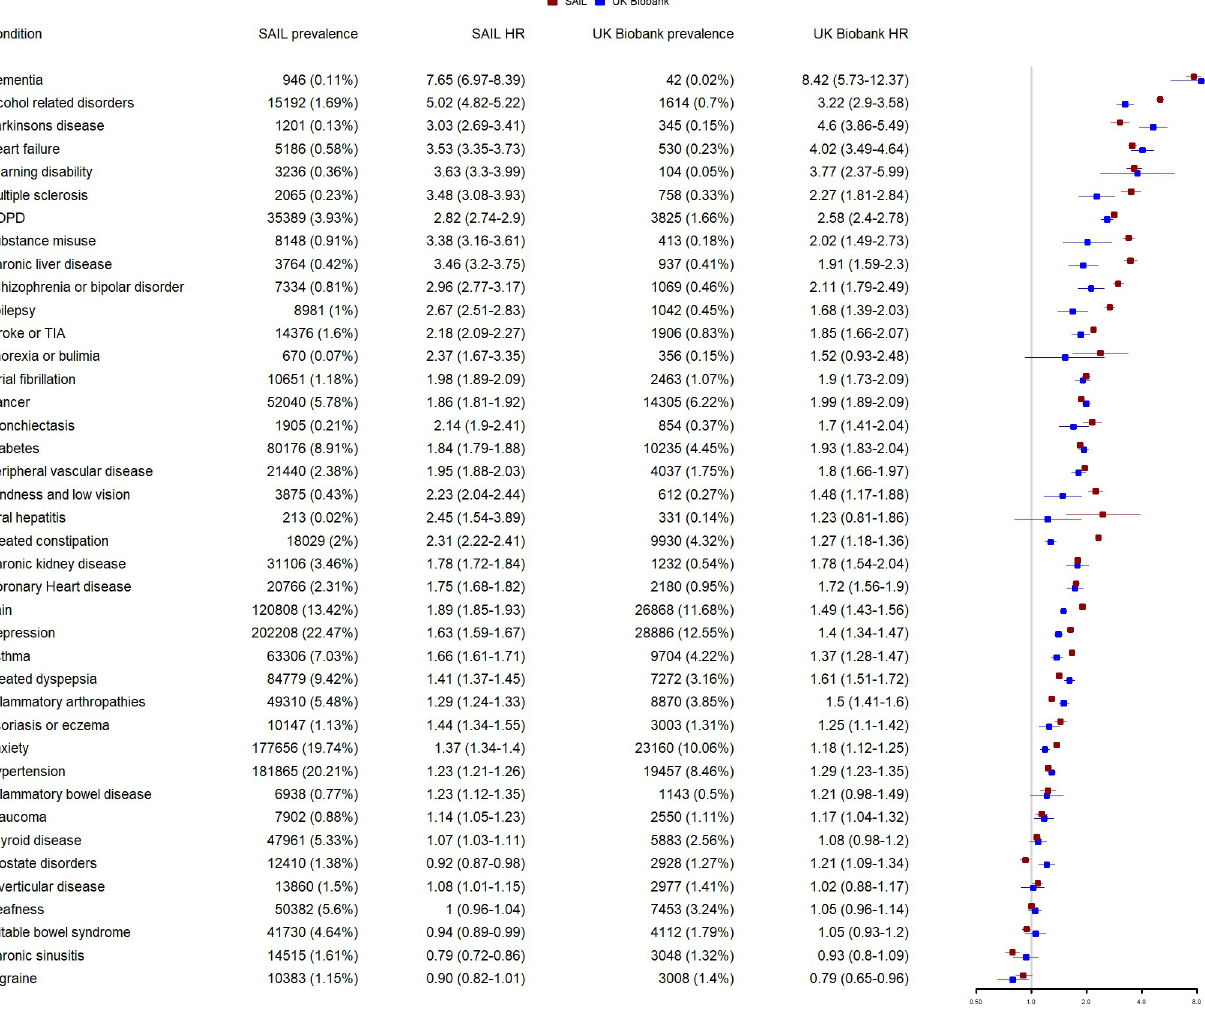
Fig 9. Relationship between each LTC and all-cause mortality in UK Biobank and SAIL. Points indicate HRs adjusted for age, sex, and socioeconomic status. Whiskers indicate 95% CIs. Conditions are ordered by the mean HR (of UK Biobank and SAIL) for each condition. CI, confidence interval; COPD, chronic obstructive pulmonary disease; HR, hazard ratio; LTC, long-term condition; SAIL, Secure Anonymised Information Linkage; TIA, transient ischaemic